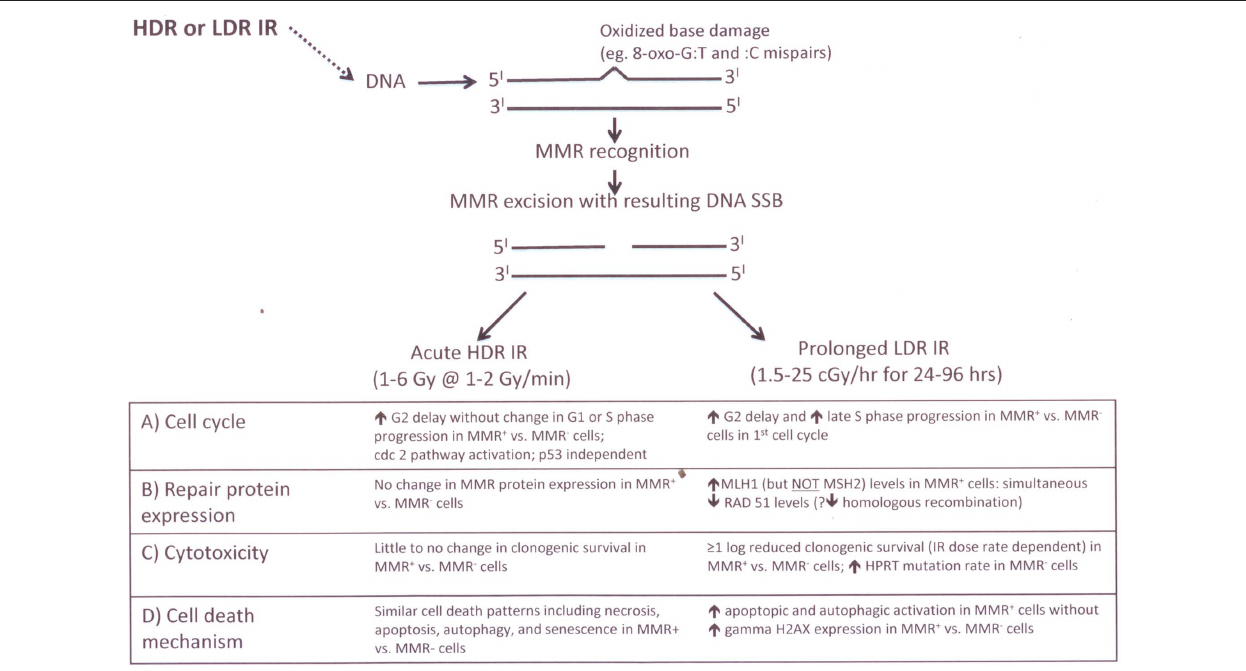
Figure 3 | Current stains of experimental biology model of MMr processing of ir-induced base damage following acute iiDr and prolonged LDr ir